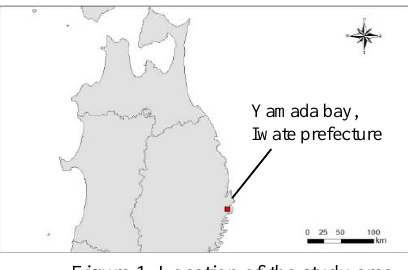
Figure 1. Location of the study